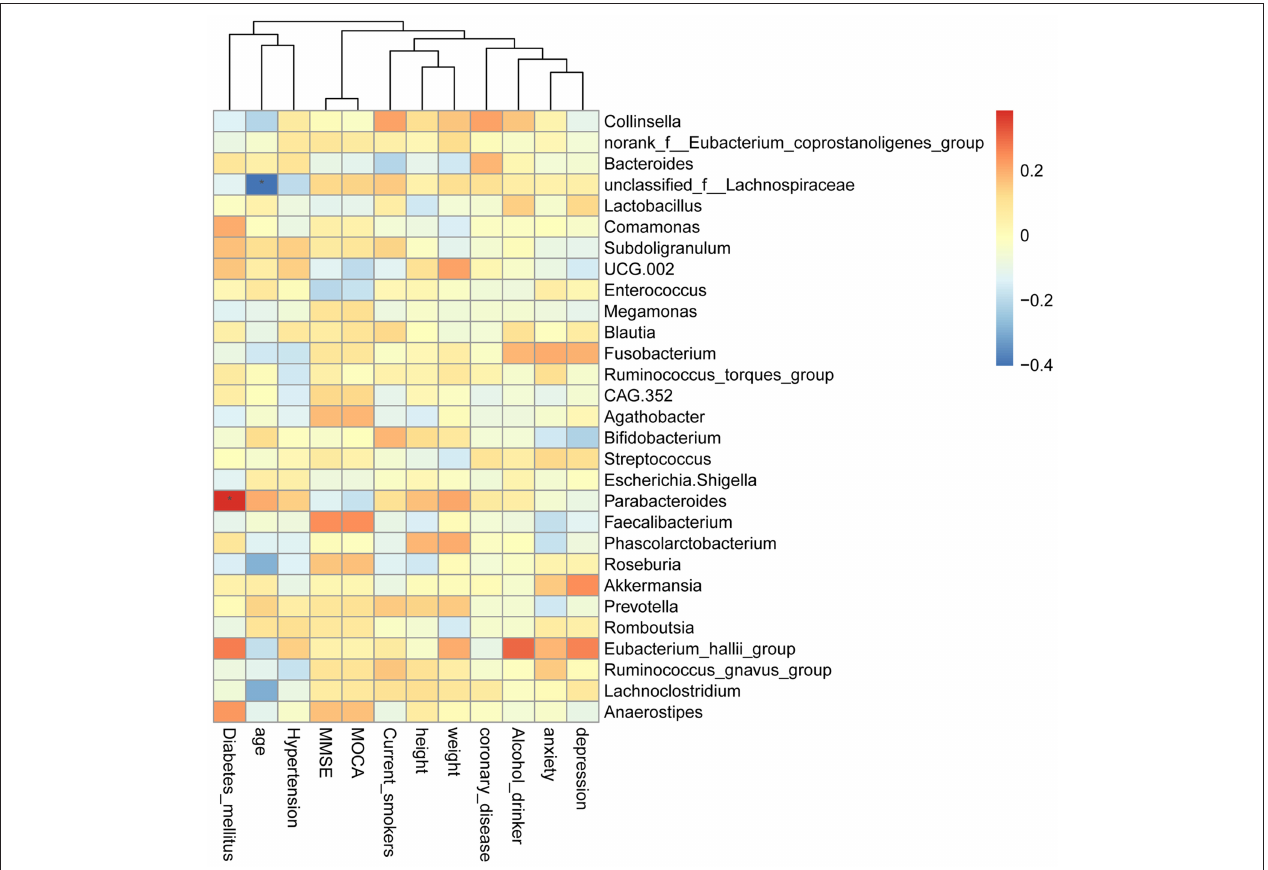
FIGURE 9 | Heatmap of spearman rank correlation analysis between GM and MOCA score and its sub-variables. Parabacteroides (P < 0.05) , Eubacterium_hallii_group and Anaerostipes were found to be positively associated with diabetes_mellitus. Unclassified_f__Lachnospiraceae , Roseburia, and Lachnoclostridium were negatively correlated with